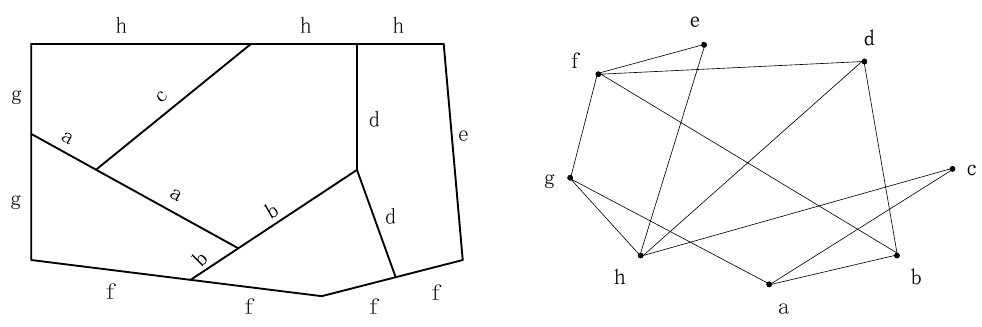
Figure 2. Two types of representations for a road network.